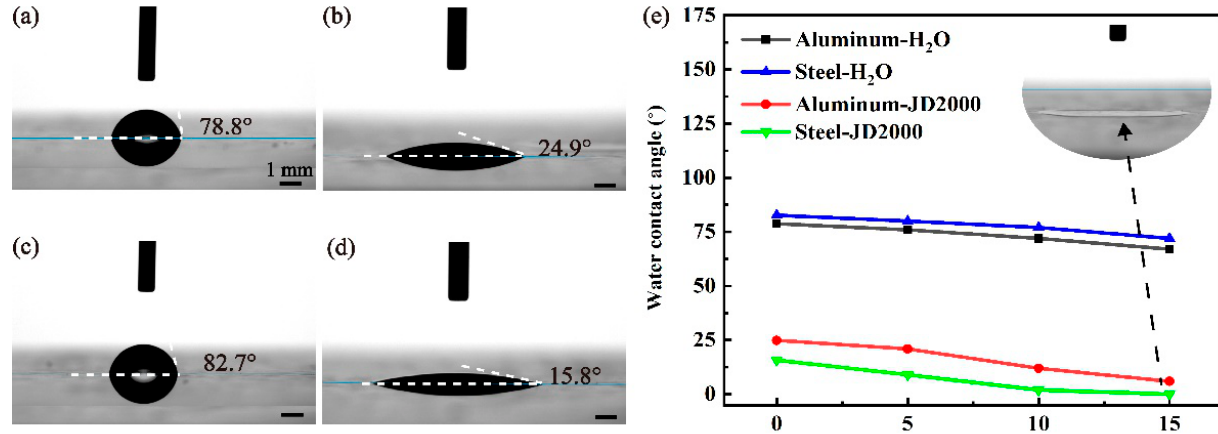
Figure 11. Aqueous contact angle goniometry dip-coated with: ( a ) distilled water on the steel plates; ( b ) 2 wt.% JD2000 on the steel plates; ( c ) distilled water on the aluminum plates; and ( d ) 2 wt.% JD2000 on the aluminum plates. ( e ) The adsorption curves.